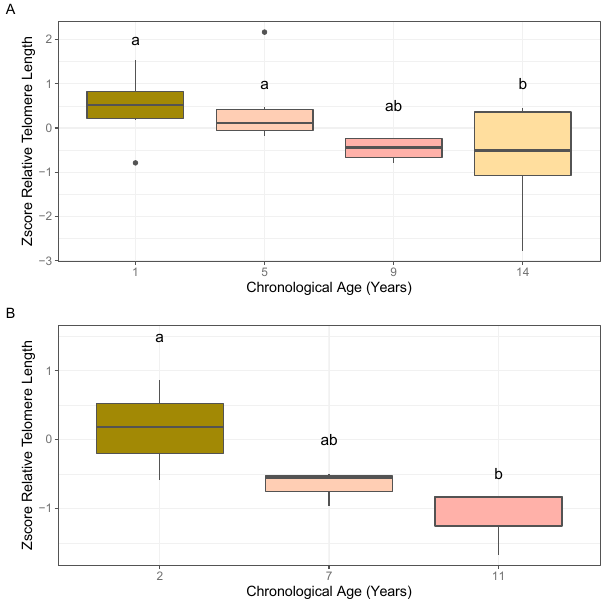
Figure 2. Boxplots depicting the calculated z-score of the T/S ratio for leaf samples within the age cohorts tested. ( A ) Age cohort collected in 2018. ( B ) Age cohort collected in 2019. Significant differences in z-scores between age cohorts based on ANOVA followed by post hoc Fisher’s least significant difference (LSD) ( α = 0.1) are denoted by letter groupings where differing letters indicate significant differences following means separation analysis (ANOVA 2018 p -value = 0.1077; ANOVA 2019 p -value = 0.06548). Bold dots represent outliers within each age cohort.